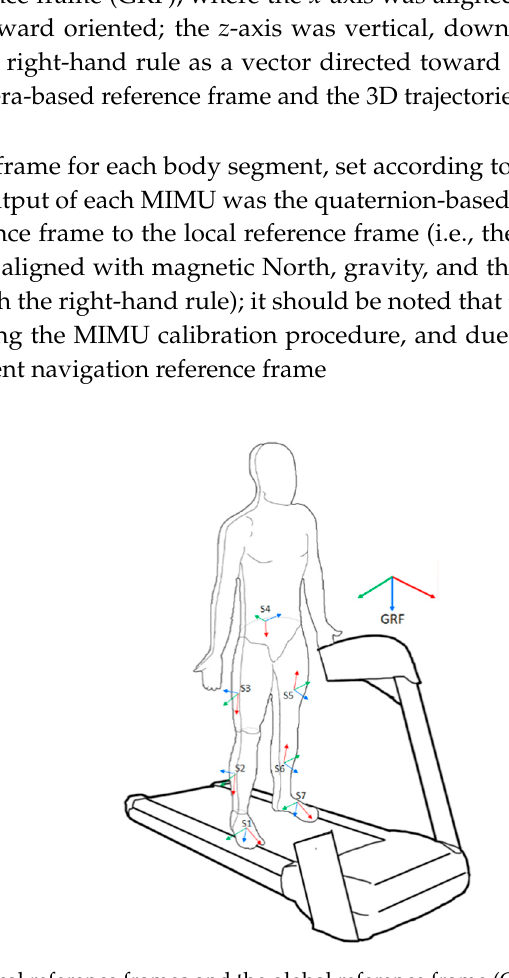
Figure 2. MIMUs’ local reference frames and the global reference frame (GRF). The red, green, and blue axes represent the x -, y -, and z -axes, respectively.